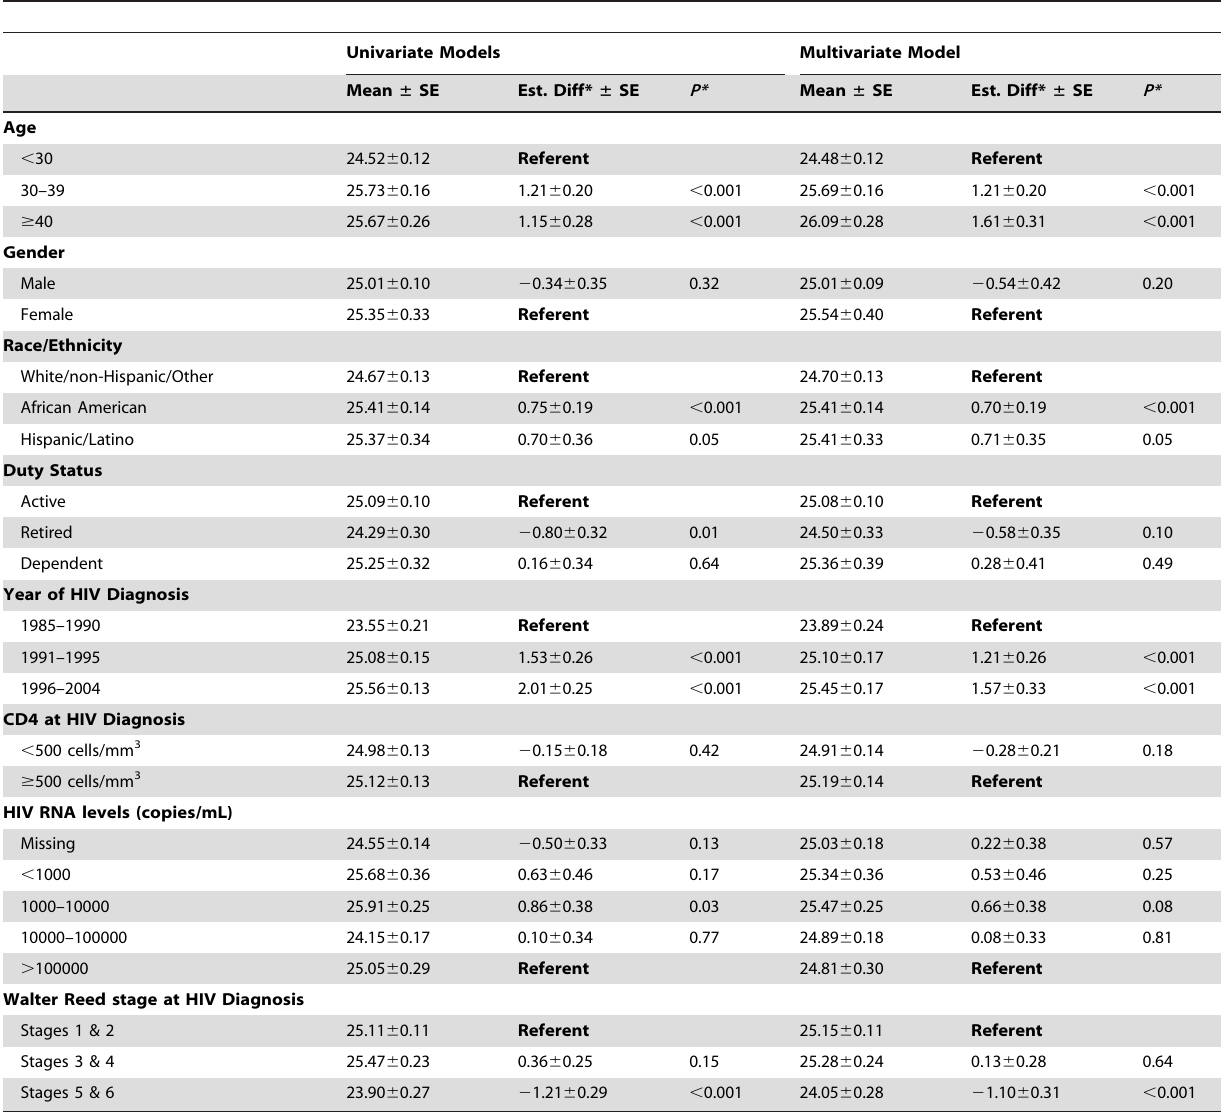
Table 2. Factors Associated with BMI at Time of HIV Diagnosis.